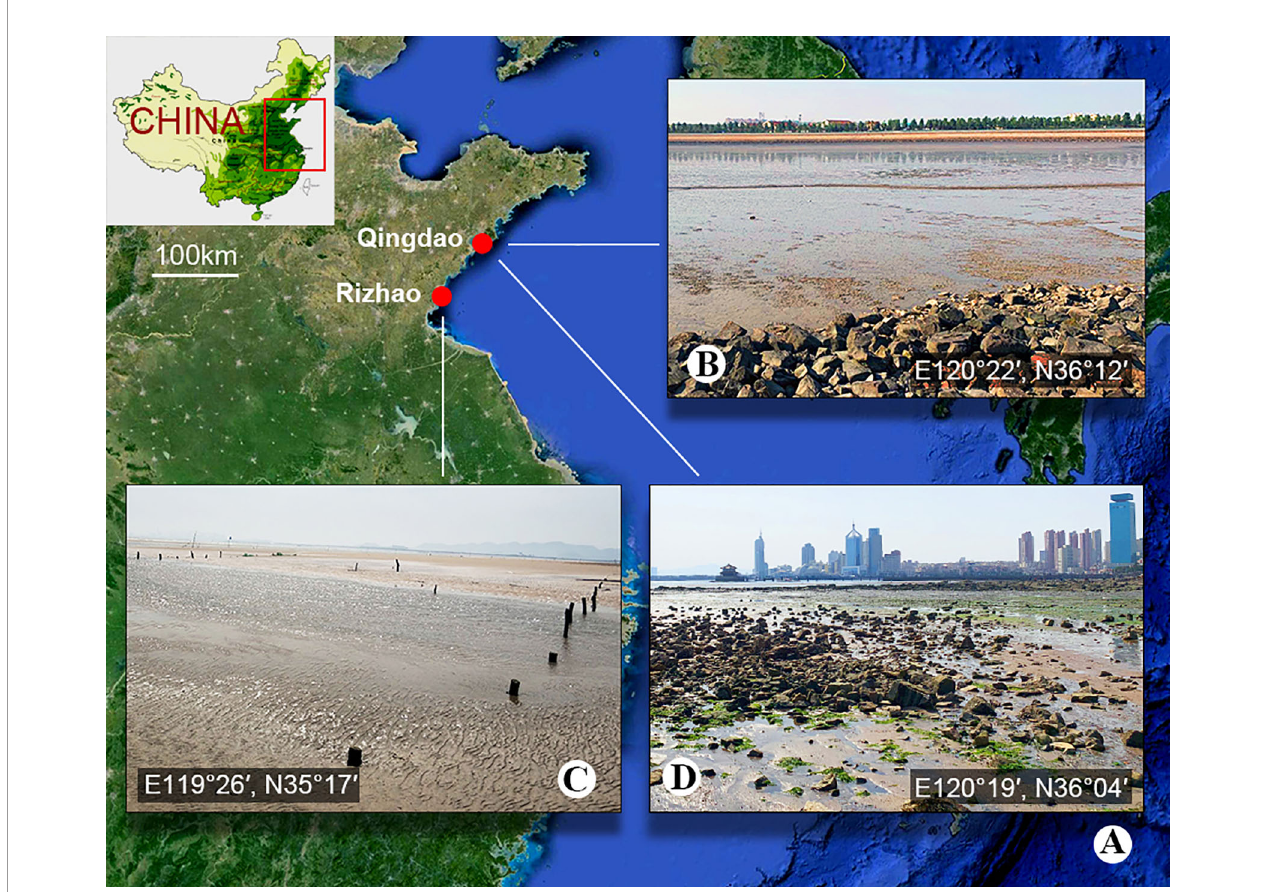
FIGURE 1 | Sample location. (A) Map showing the location of Qingdao and Rizhao, China. (B) The sludge-rich beach of Bainidi in Qingdao. (C) The beach of Liujiawan in Rizhao. (D) The sewage outfall of Zhanqiao Pier in